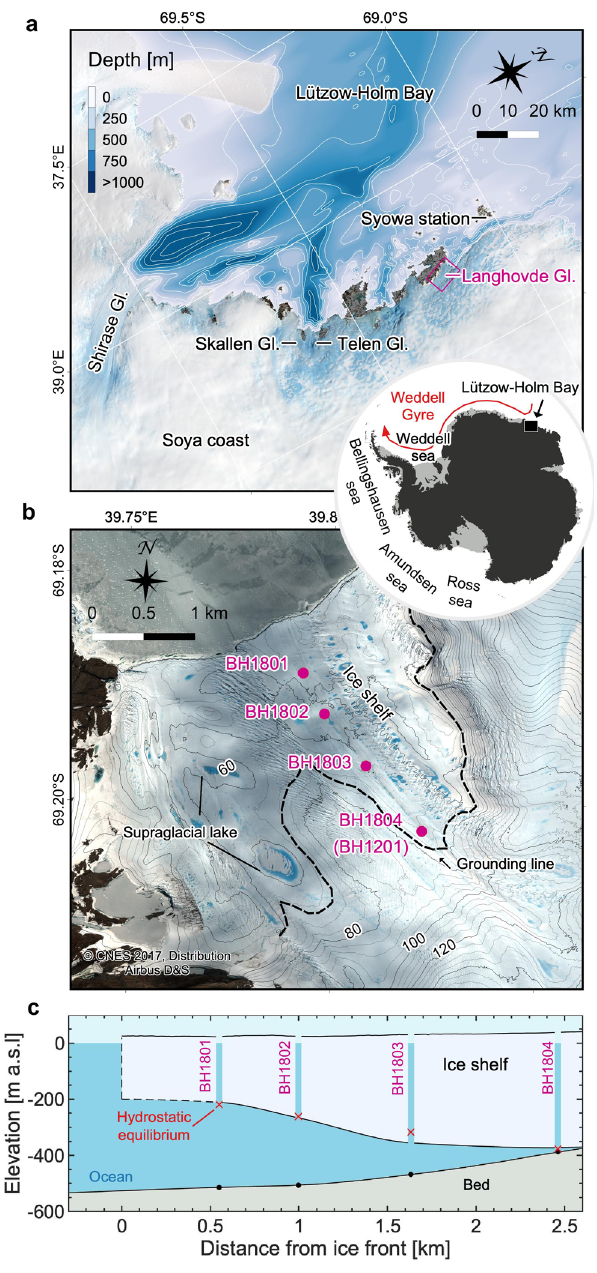
Fig. 1 Study site. a Satellite image of Lützow-Holm Bay obtained by Landsat 8 on 11 November 2017. The contour lines indicate the ocean depth with intervals of 200 m. The location of Lützow-Holm Bay in Antarctica is indicated in the inset. Red arrow is a schematic representation of the Weddell Gyre after Fig. 7 in ref. 25 . b Locations of the drilling sites along the ice shelf of Langhovde Glacier (purple dots). The image and surface elevation were acquired by Plèiades on 21 December 2017. The surface elevation contour lines are every 5 m. Black dashed curve indicates the grounding line estimated by the break in slope method 20 . c Vertical cross-section of Langhovde Glacier along the boreholes. The red crosses are the ice bottom elevation estimated from the surface elevation based on the hydrostatic equilibrium assumption. The surface elevation (black contour) was obtained from elevation model of Plèiades 47 . The lower boundary of the ice shelf and the ocean bed were drawn by interpolation of borehole measurements and bathymetry map in front of the ice